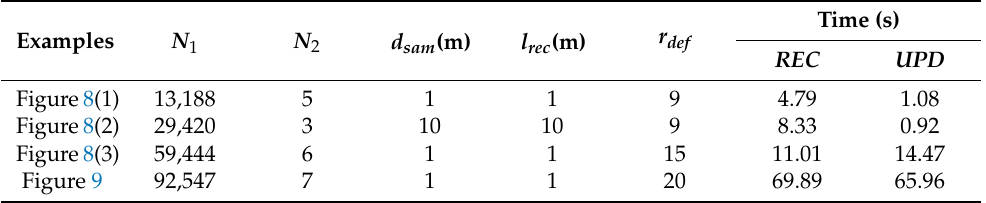
Table 1. The parameters and running time for the experiment examples, including the number of model facets ( N 1 ), the number of control polylines ( N 2 ), the reconstruction time ( REC ), and the updating time ( UPD